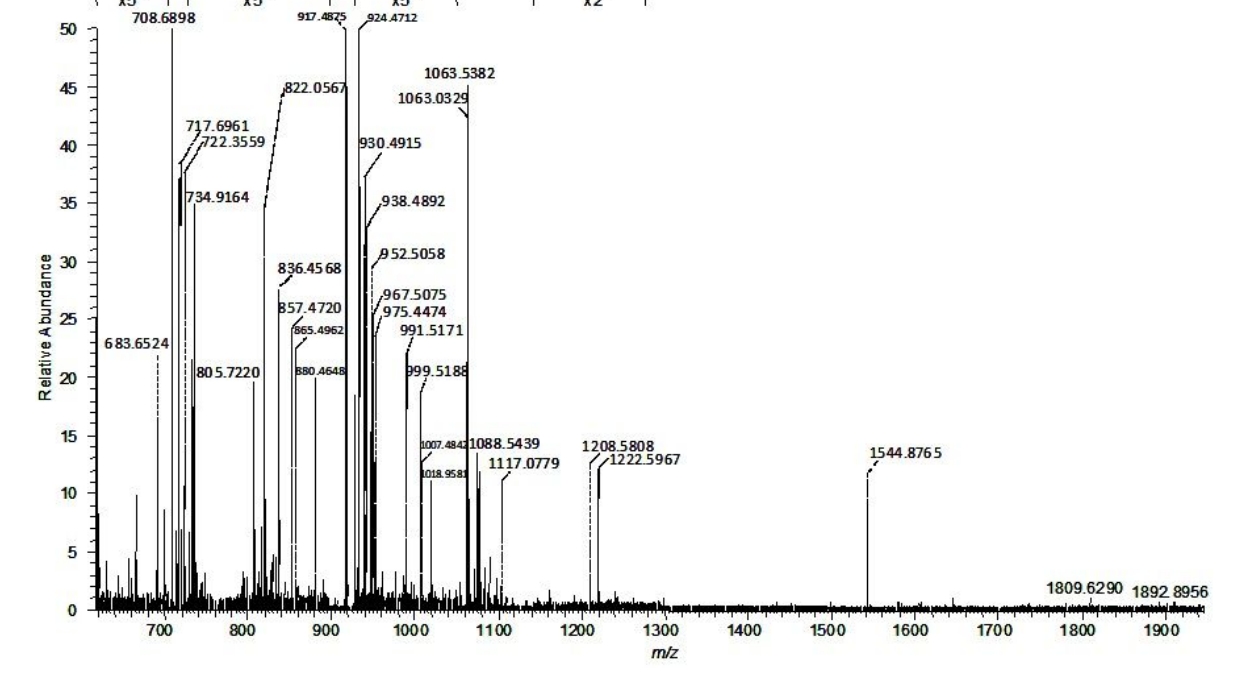
Figure 3. ( − ) NanoESI HR MS of ganglioside mixture derived from control hippocampal tissue sample. Conditions as in Figure 2.